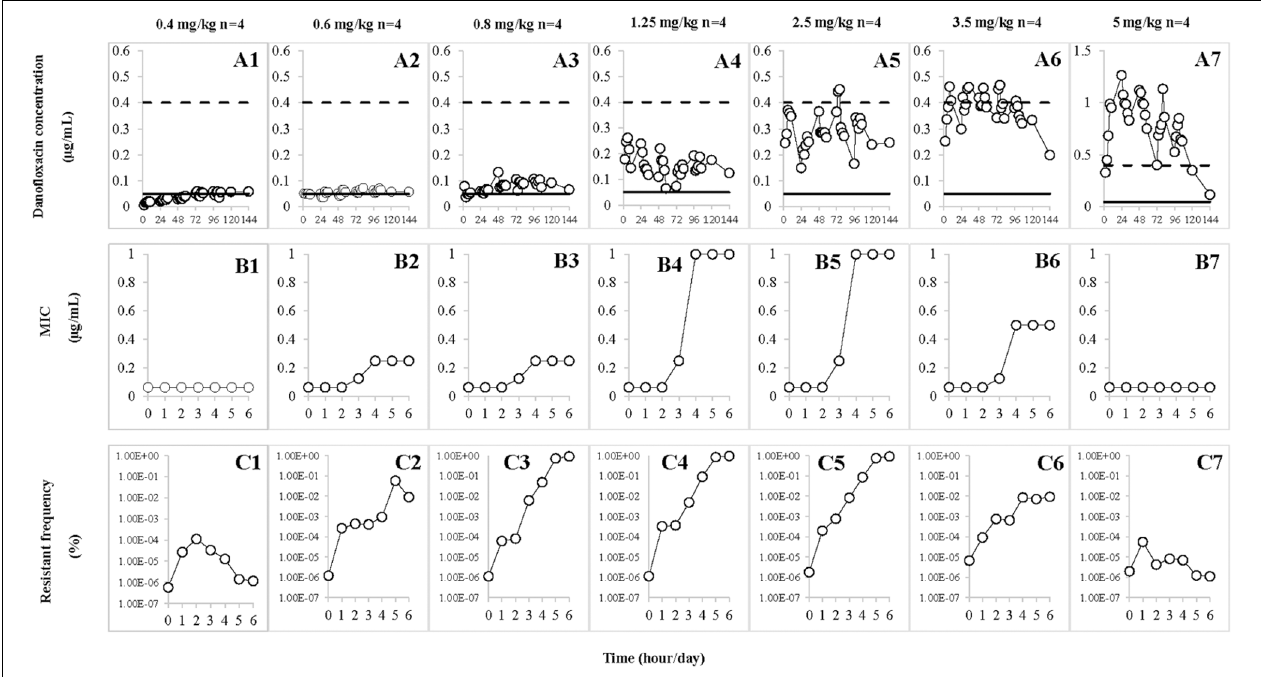
FIGURE 3 | Effect of danofloxacin concentration on loss of susceptibility and mutant enrichment. Concentrations of danofloxacin (0.4, 0.6, 0.8, 1.25, 2.5, 3.5, and 5 mg/kg) correspond to the different treatment groups once daily for 5 days. n is the number of tissue cages per group. (A1–A7) The concentration–time curves of different dosages of danofloxacin. (B1–B7) The values of MIC after each administration of danofloxacin, which corresponded to A1–A7 . (C1–C7) The resistant frequency after each administration of danofloxacin, which corresponded to A1–A7 . The dotted line represents MPC and the solid line represents MIC 99 in A1–A7 .